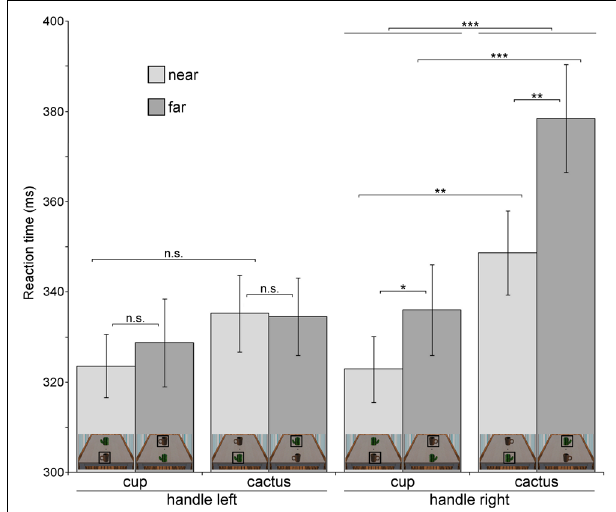
FIGURE 4 | Reaction times in the probe detection task for each of the eight experimental conditions (Experiment 2). For clarity, miniature pictures of the stimulus in each condition are shown at the bottom of each bar.The object at which the luminance probe occurred in a specific condition is marked with a black square. Error bars denote ± 1 SEM. Significance levels are indicated for effects of interest. * p < 0.05, ** p < 0.01, *** p < 0.001, n.s.-not